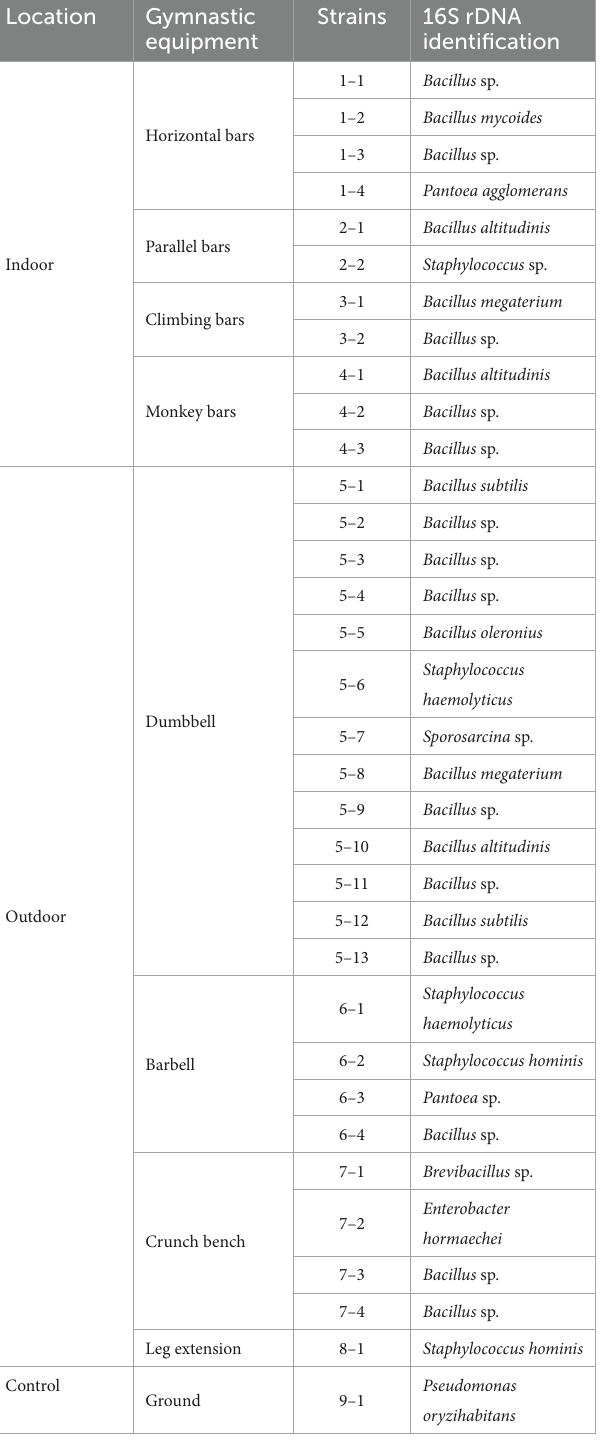
TABLE 1 Strains isolated from gymnastic equipment surfaces.